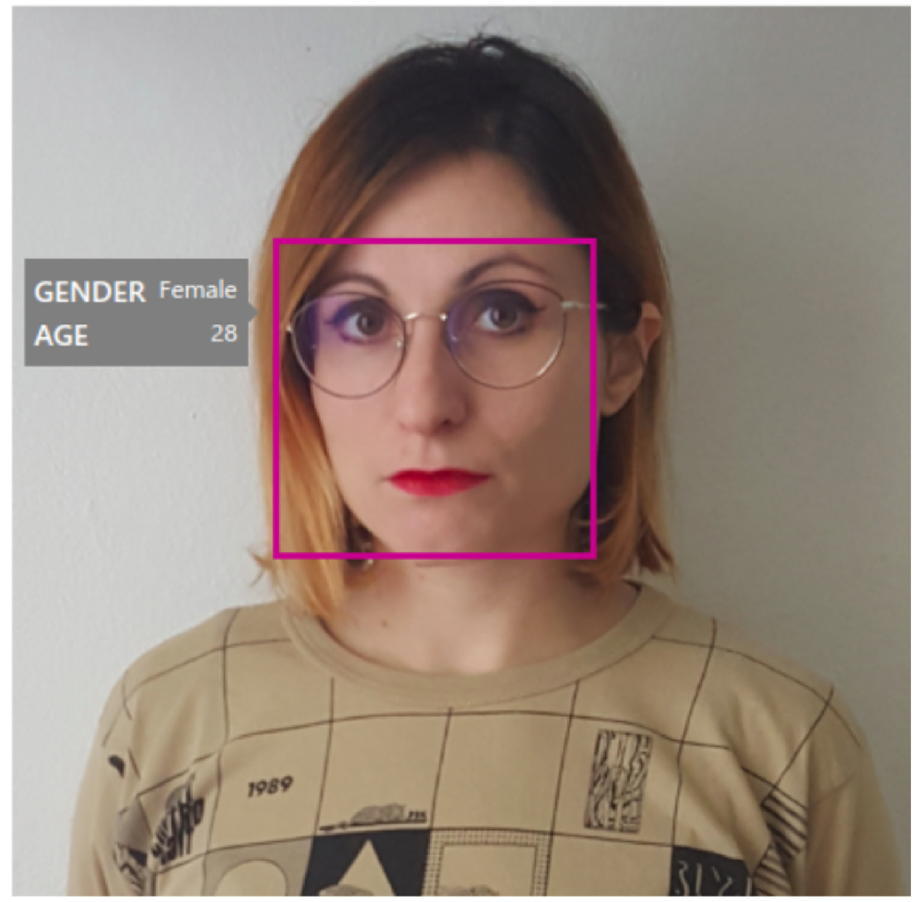
Fig 2. An example of the output of Microsoft Vision CNN algorithm (Printed under a CC BY license, with permission from the subject of the picture, original copyright 2018).